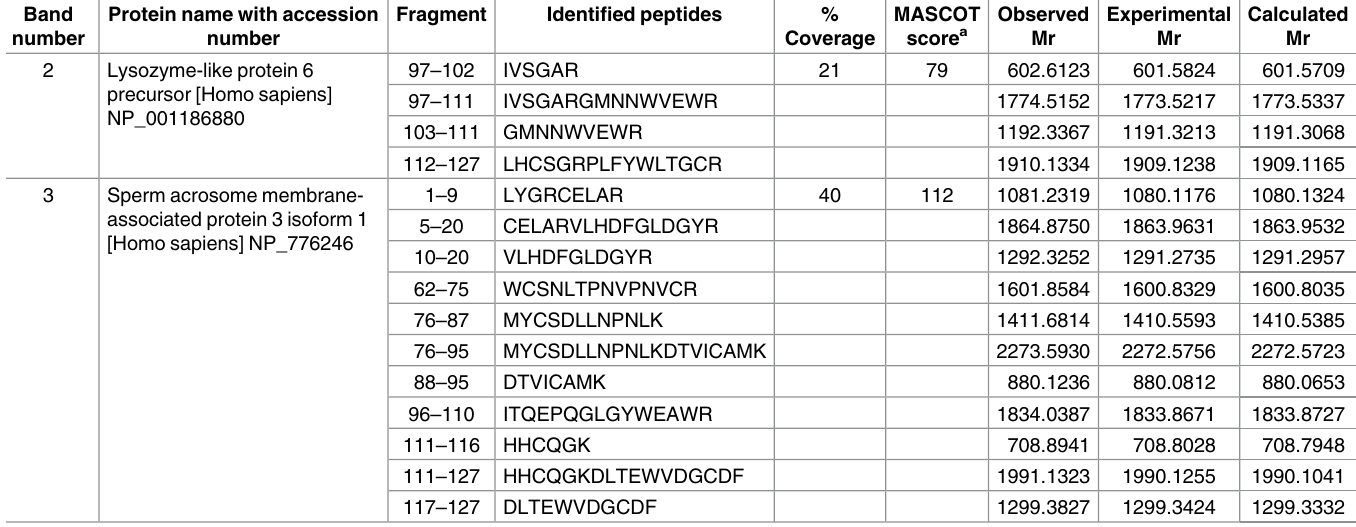
Table 2. The identified LYZLs by MALDI-TOF/TOF